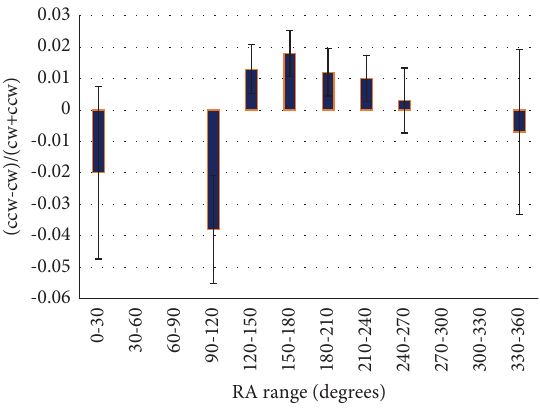
Figure 5: Asymmetry in diferent RA